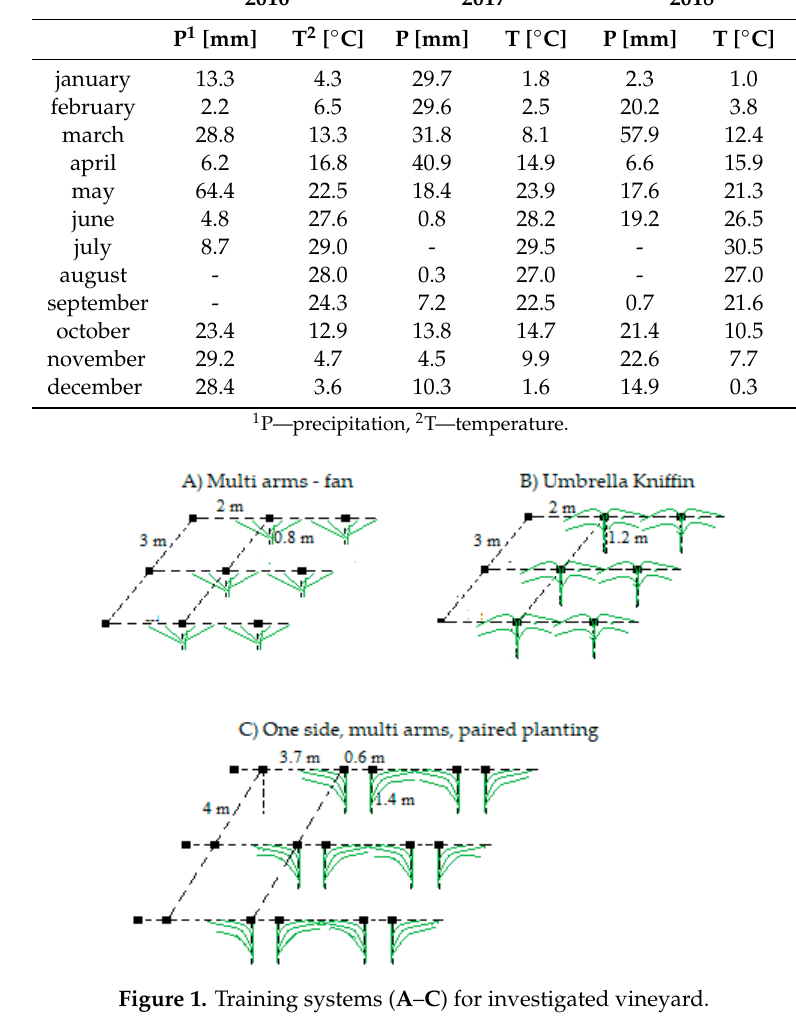
Table 1. Temperature and precipitations in Ghafurov region in 2016–2018.